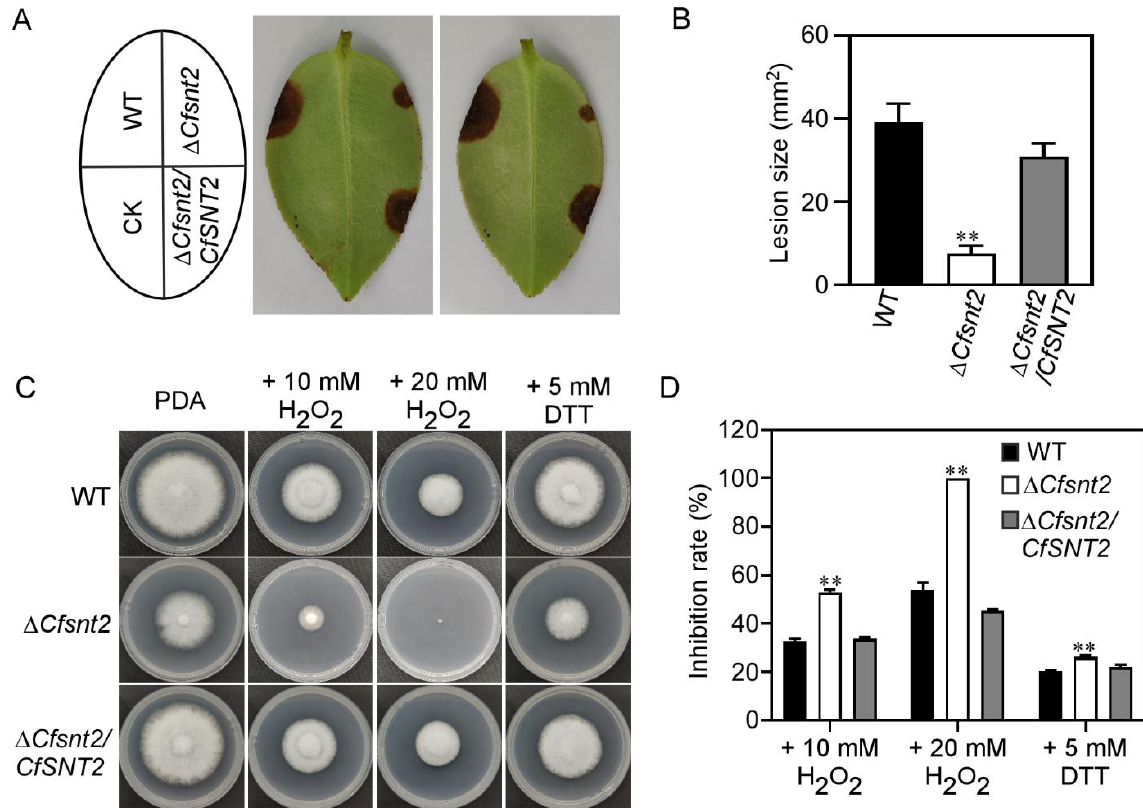
Figure 8. CfSnt2 regulates pathogenicity and the responses to oxidative and ER stresses. ( A ) Wounded C. oleifera leaves were inoculated with mycelial plugs of WT, Δ Cfsnt2 , and Δ Cfsnt2/CfSNT2 . Diseased symptoms were observed at 4 days post inoculation. CK: control check, agar plugs were inoculated on wounded leaves. ( B ) Statistical analysis of lesion sizes measured by Image J. Asterisks represent significant differences (** p < 0.01). ( C ) The s trains of WT, Δ Cfsnt2 mu- tant, and Δ Cfsnt2/CfSNT2 were incubated in PDA media or PDA media with H 2 O 2 and DTT at 28 °C for 3 days. ( D ) Statistical analysis of inhibited rates of the strains to oxidative and ER stresses. Three independent experiments were performed with three biological replicates each time. Error bars indicate SD of three replicates (** p < 0.01).